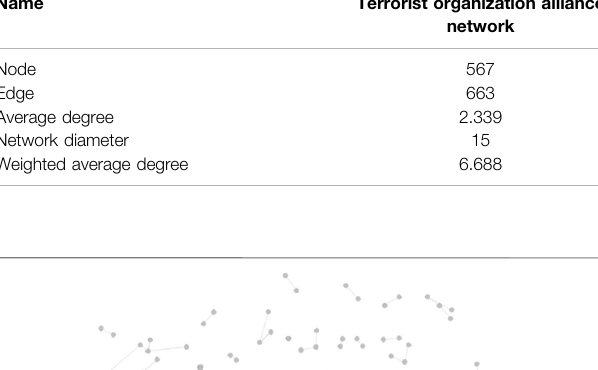
FIGURE 4 | The degree of TOA Network: Plot the number of the degree on the vertical Y -axis to logarithmic against weight degree on the horizontal x -axis to logarithmic.